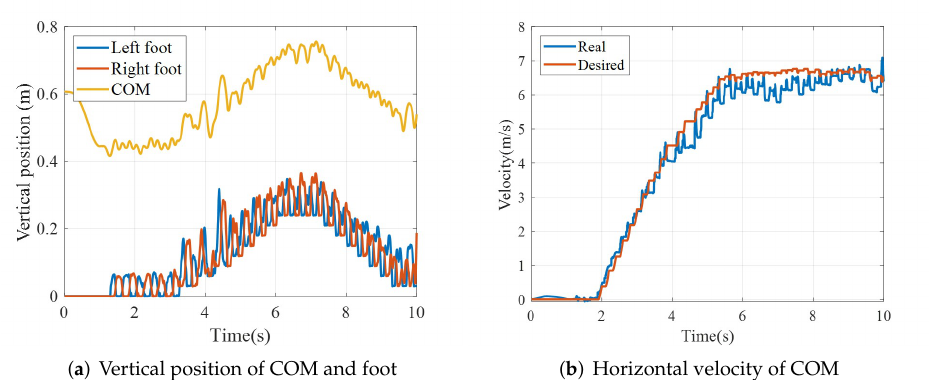
Figure 12. Simulation of running up and down stairs (Case 1).